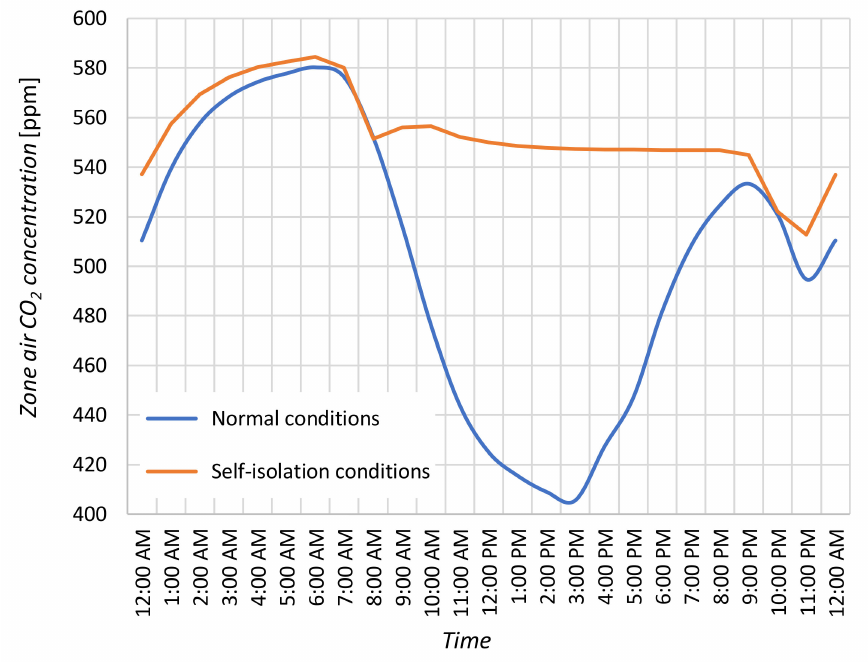
Figure 17. Change the CO 2 concentration for the presence of seven people in the house.